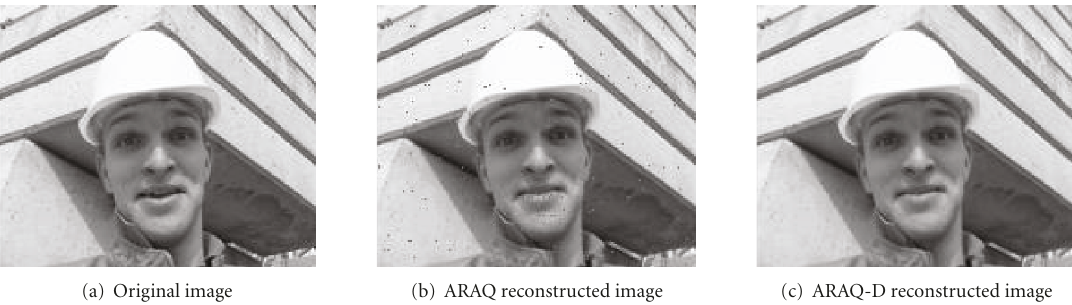
Figure 14: Snapshot from the Foreman sequence. (a) Original image. (b) ARAQ reconstructed image with M = 1 and ρ = 0 . 25. (c) ARAQ-D output image obtained by replacing the frame with its corresponding side